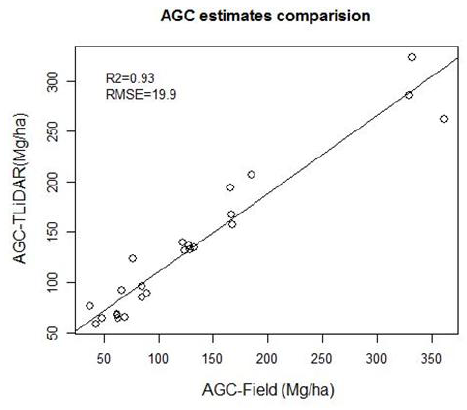
Figure 13. Comparison of AGC stocks